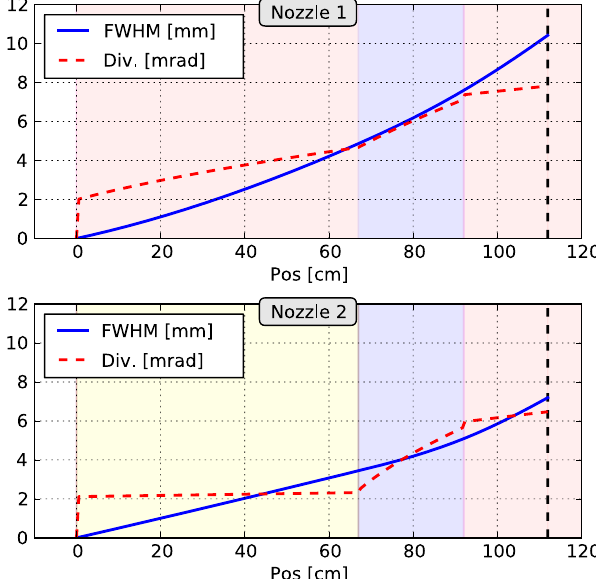
FIG. 9. FWHM and divergence of a 60 MeV proton point beam impending on Nozzle 1 (top) and Nozzle 2 (bottom), 10 cm air gap. The focal point is indicated with a dashed vertical line. The background colors indicate material.